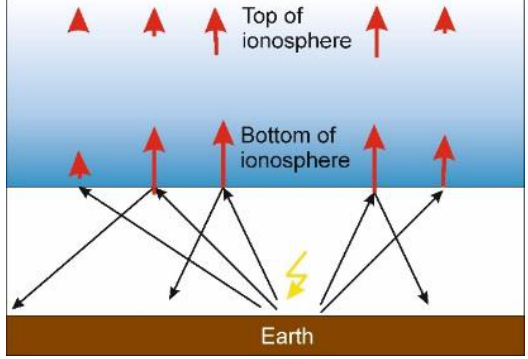
Figure 8. Coupling of sferics into the ionosphere.